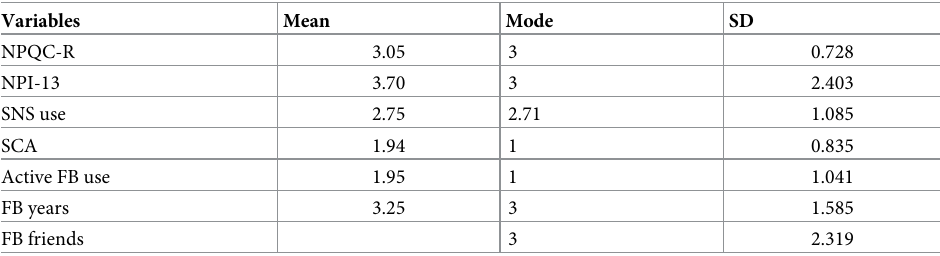
Table 1. Preliminary descriptive